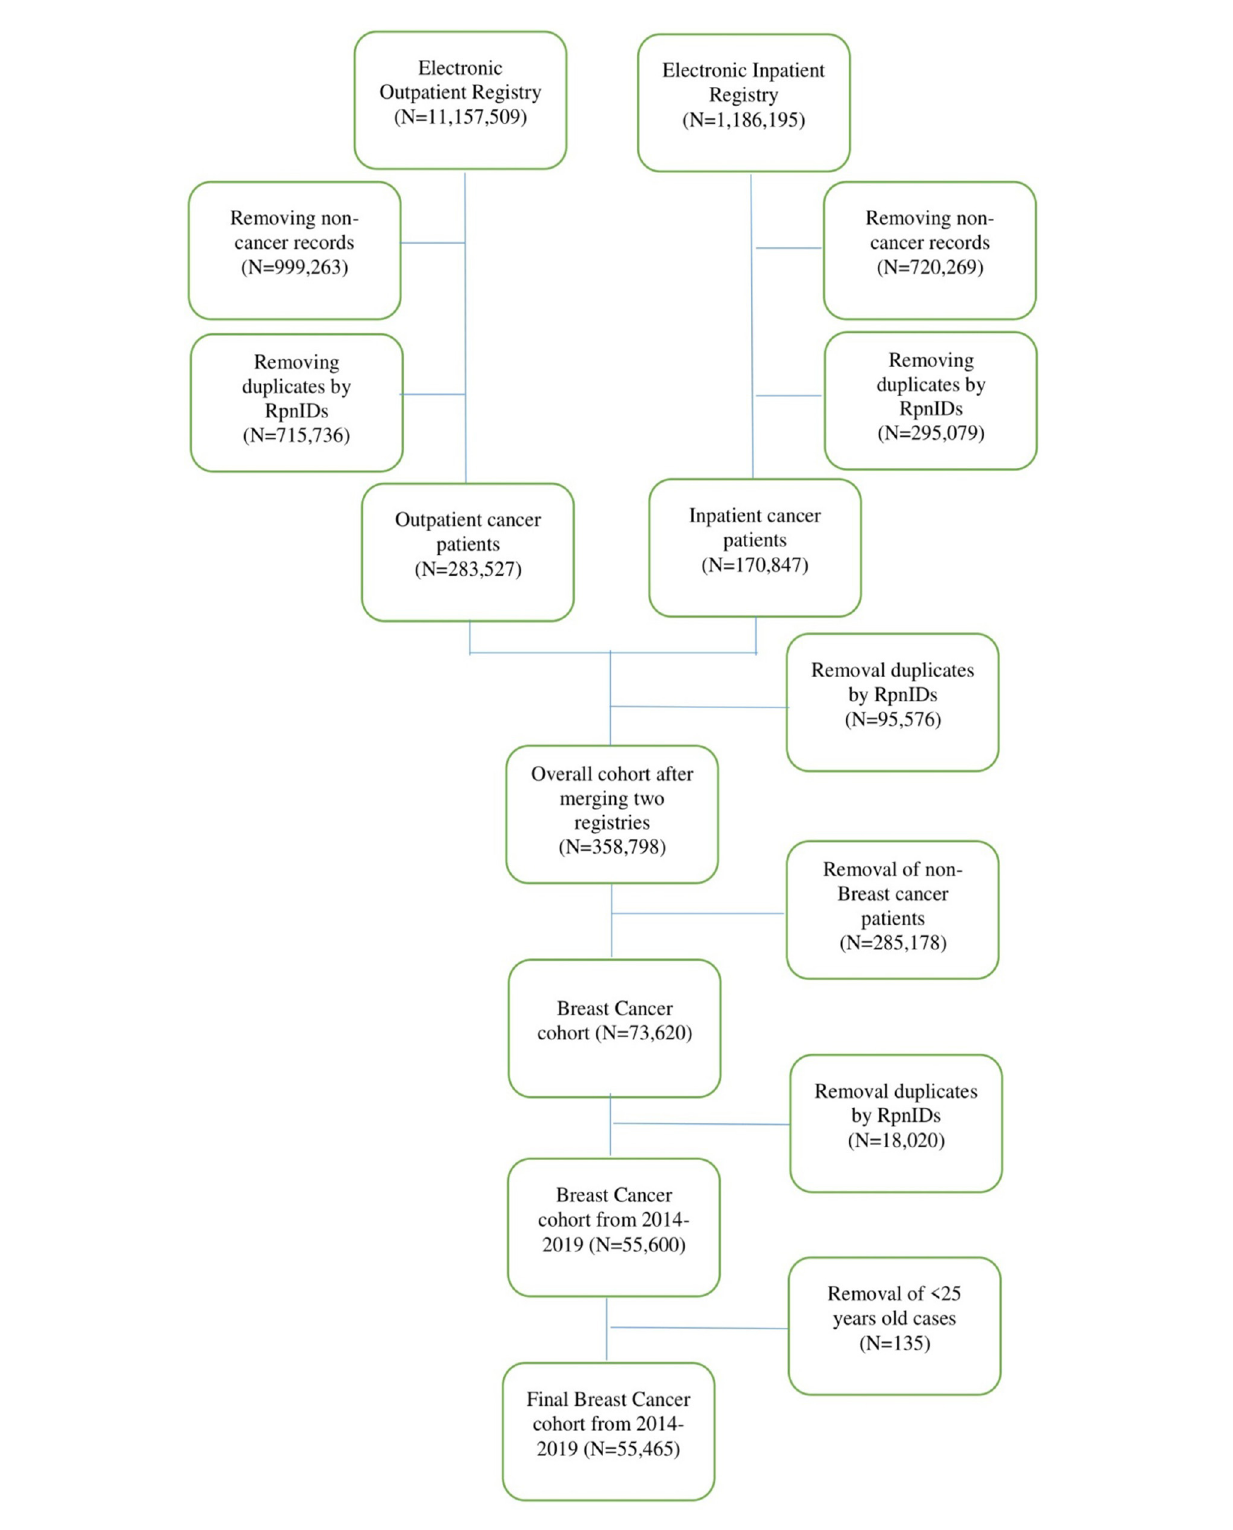
FIGURE1 Flow chart diagram of cohort